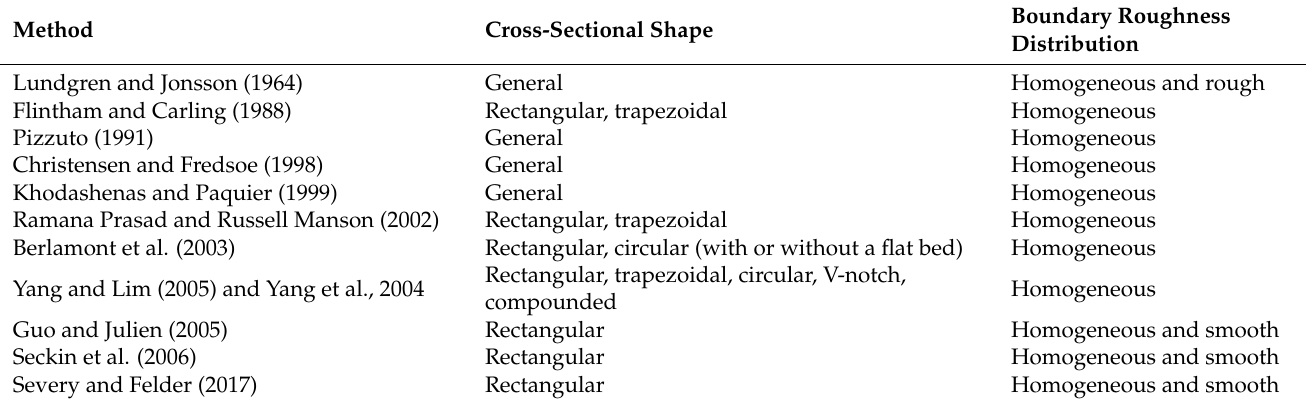
Table 1. General characteristics of methods for calculating the shear stress at the surface of a flow channel.